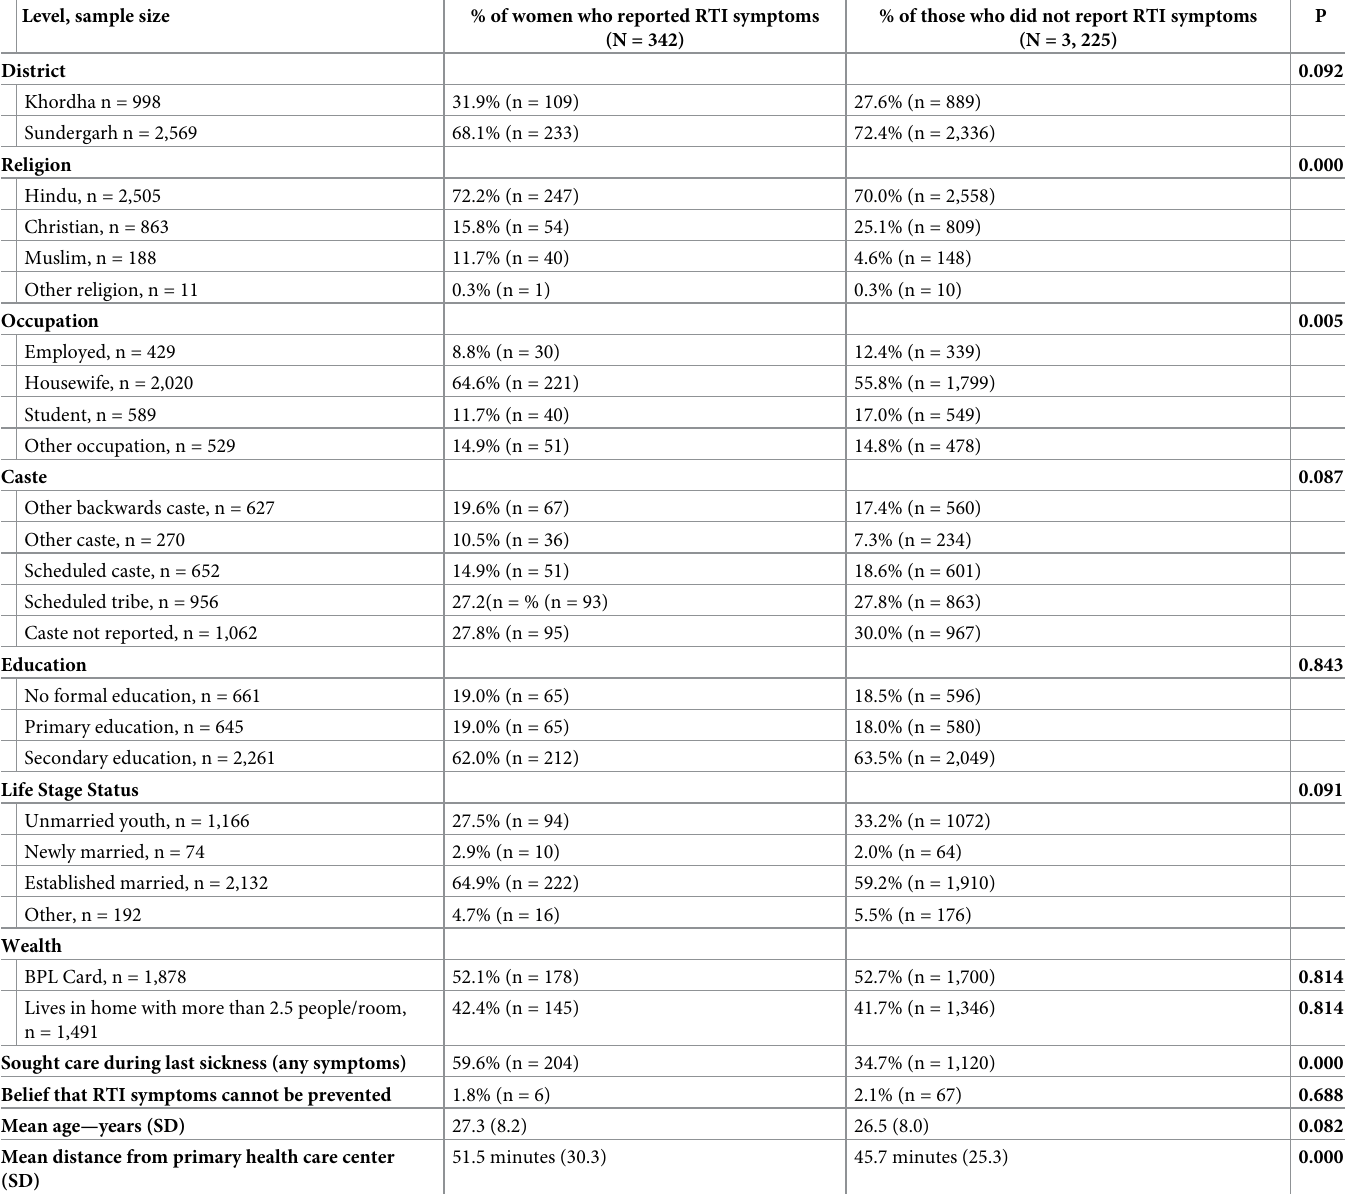
Table 2. Demographic differences between women reporting acute RTI symptoms within the last two weeks versus women with no symptoms in the last two